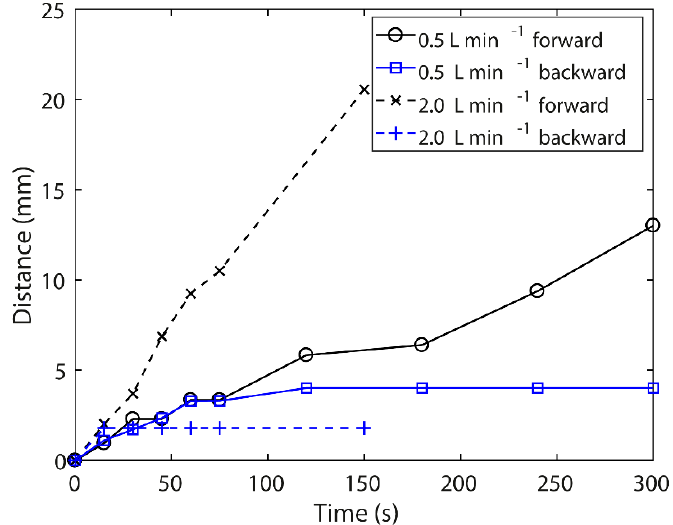
Figure 5. Liquid water penetration length for foam A.